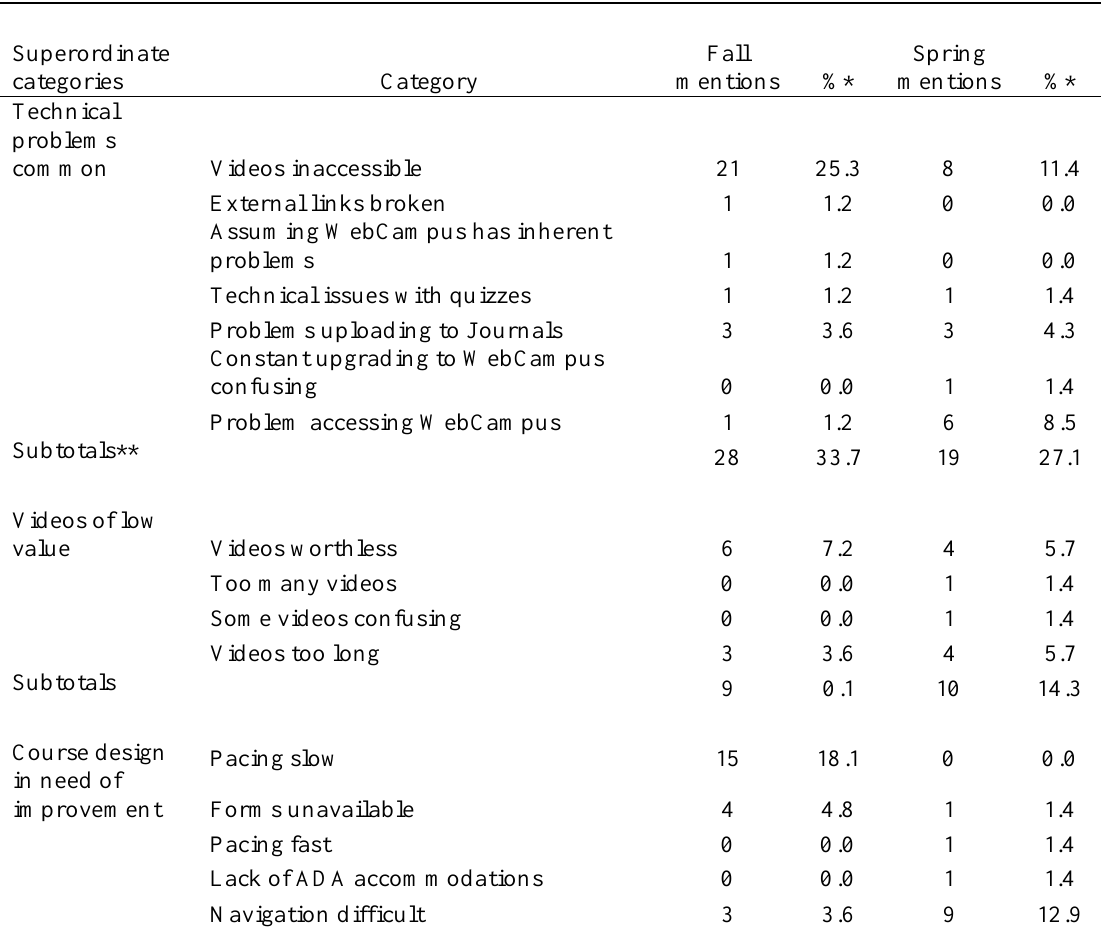
Number of Mentions and Percentages of Categories for Item 1: Issues experienced with